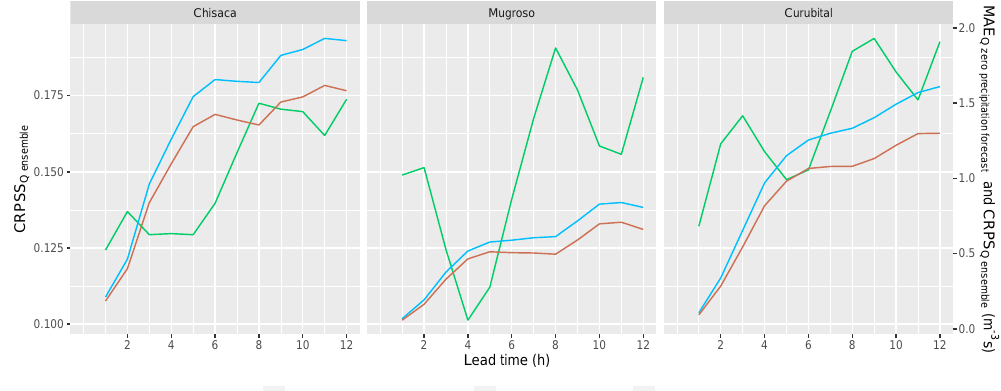
Figure 12. CRPSS for the discharge